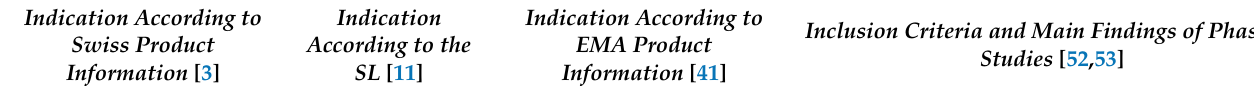
Table 4. Ozanimod (Zeposia ® ), approval CH